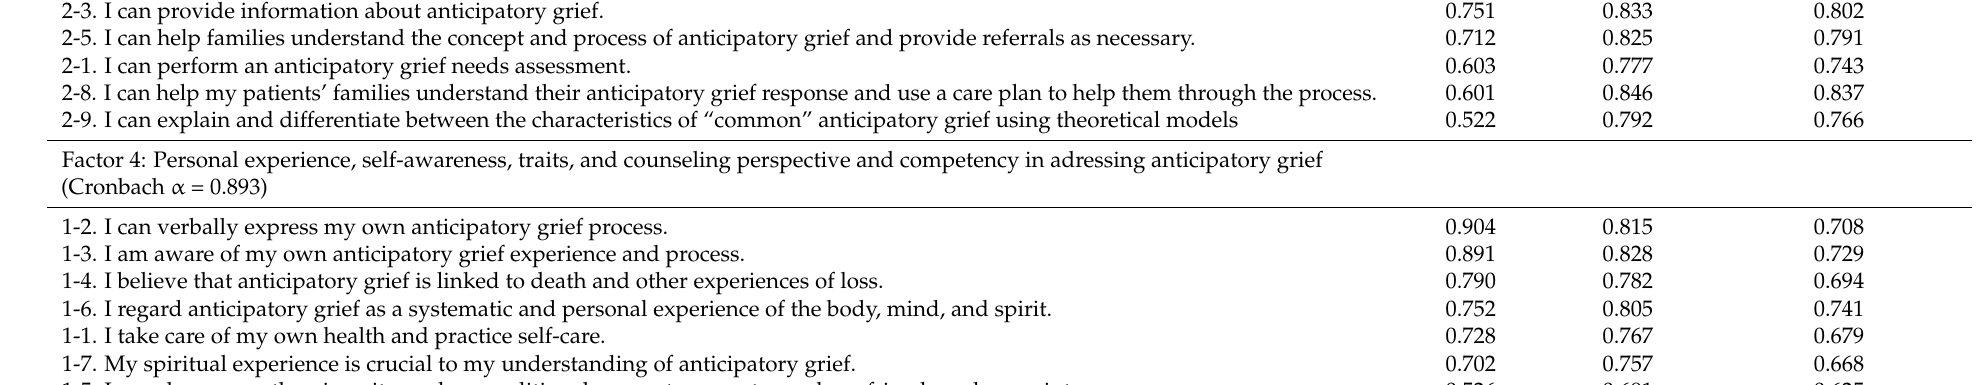
Structure Matrix